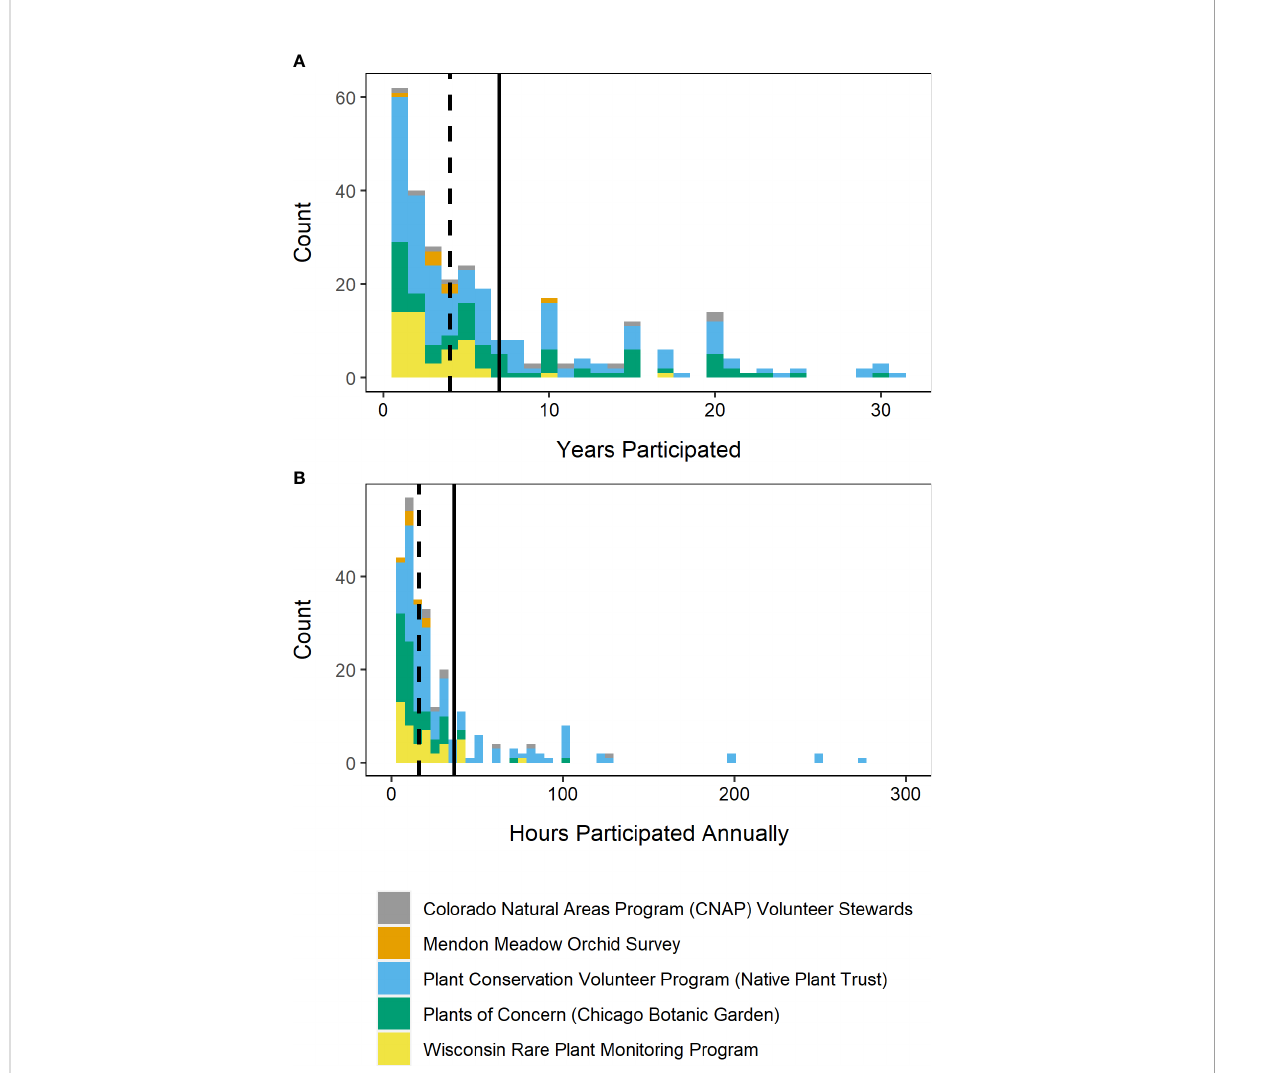
FIGURE 6 (A) Histogram of years participated by project. The mean (6.89, sd = 6.93) is shown with the solid line, and the median (4) is shown in the dashed line. (B) Histogram of number of hours that volunteers participate in the project annually. The mean (34.64, sd = 86.75) is shown with the solid line, and the median (16) is shown in the dashed line. Two outlier responses from volunteers with Plant of Concern (900 hours/year) were omitted from this